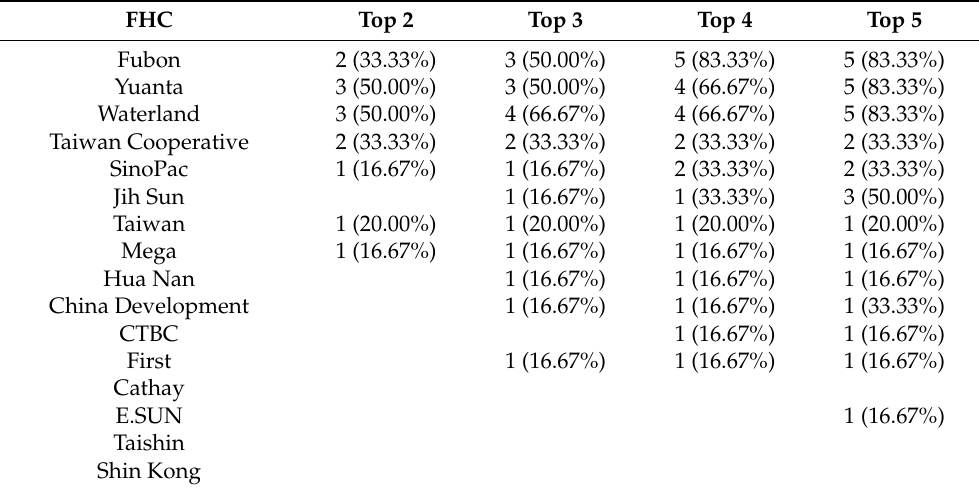
Table 12. Top-performing Taiwanese financial holding companies in Model 4 with NPLs.